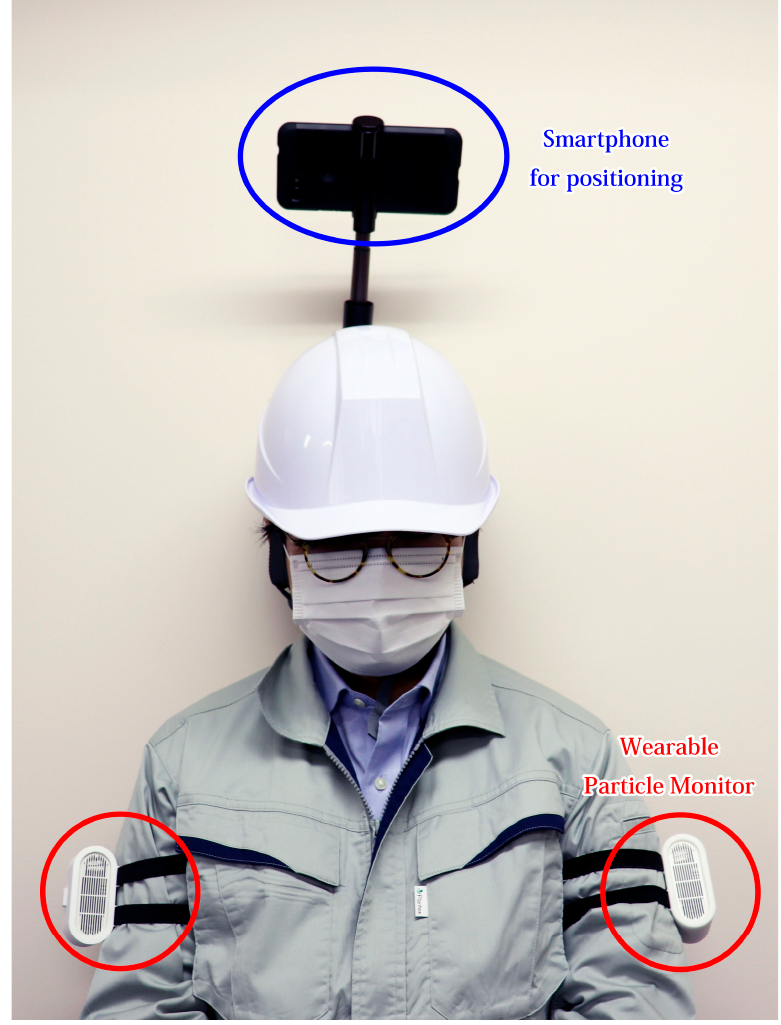
Figure 2. Photograph of the measurer. A wearable particle monitor was worn on both upper arms. A smartphone for indoor positioning was attached to the helmet using a selfie stick.